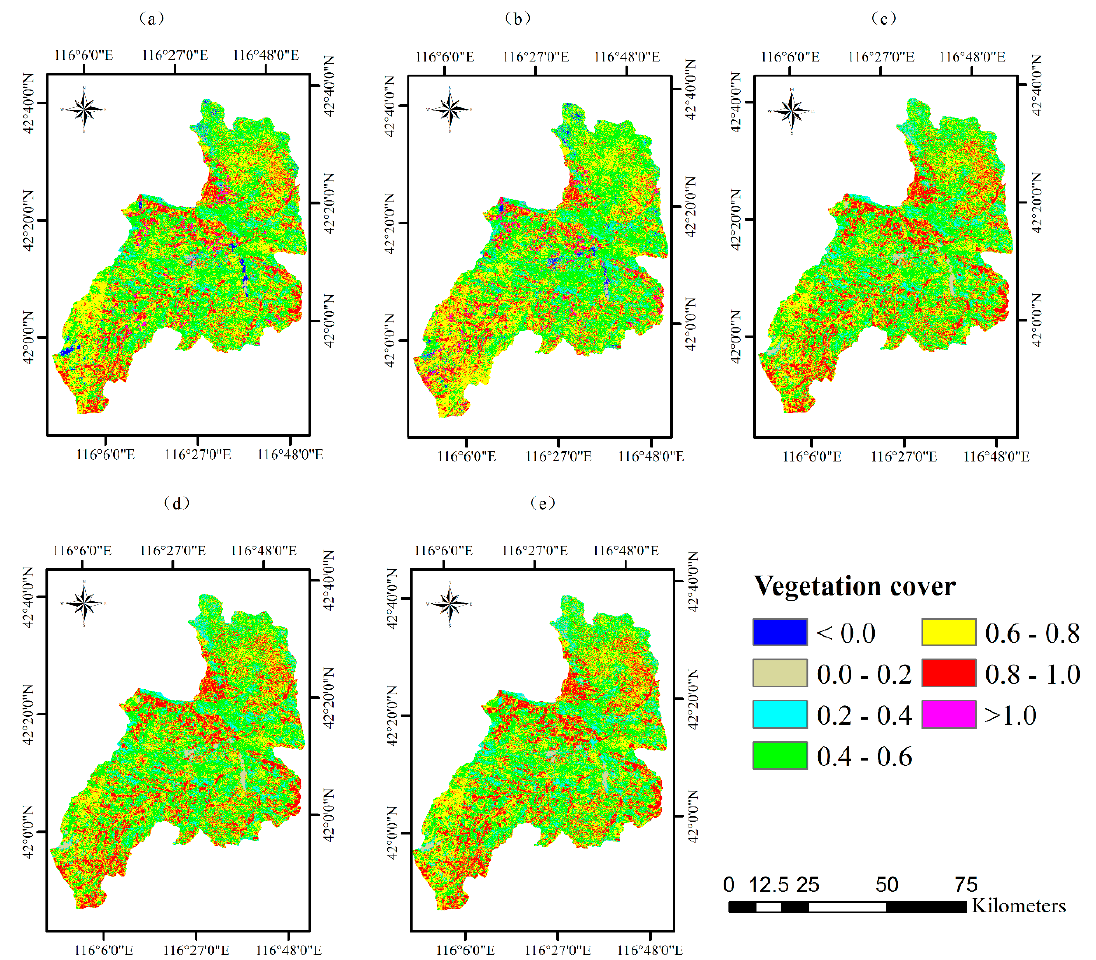
Figure 10. The spatial distributions of percentage vegetation cover predictions for Duolun County using: ( a ) Linear regression model (LSR); ( b ) Geographically weighted regression (GWR); ( c ) Constant kNN (Cons_kNN) with 11 nearest plots; ( d ) Optimized kNN (Opt_kNN); and ( e ) Random forest (RF).